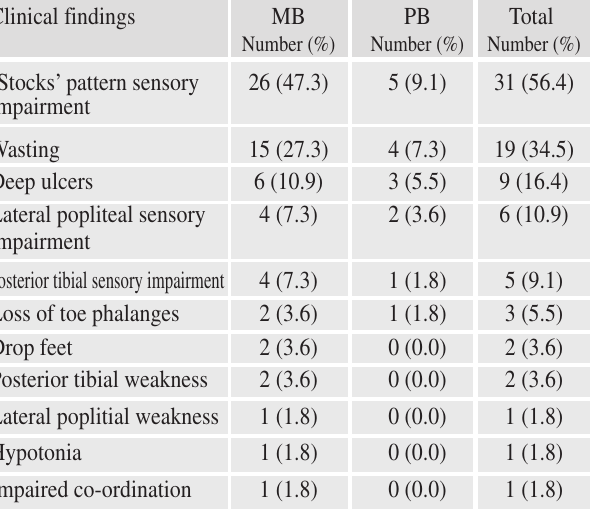
Fig 1. The common presenting neurological symptoms (some patients presented with multiple symptoms)!